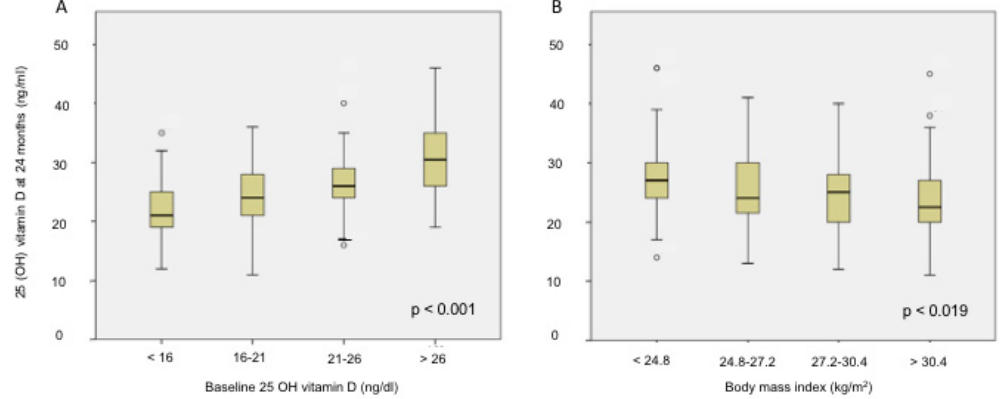
Figure 2. The 25(OH) D levels at 24 months according to quartiles of baseline 25(OH) vitamin D ( A ) and quartiles of body mass index ( B ).